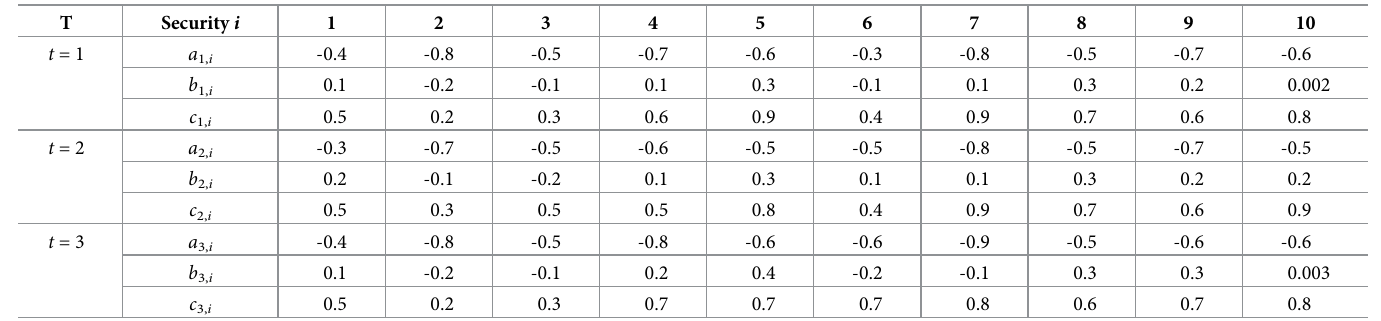
Table 1. The zigzag uncertain returns of 10 securities.